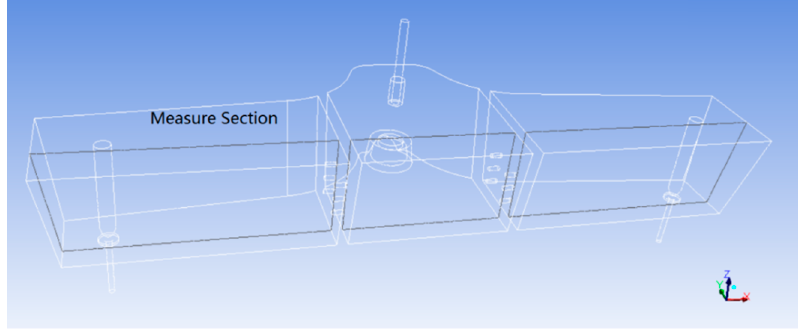
Figure 2. Schematic of the measuring section positions in the tundish.